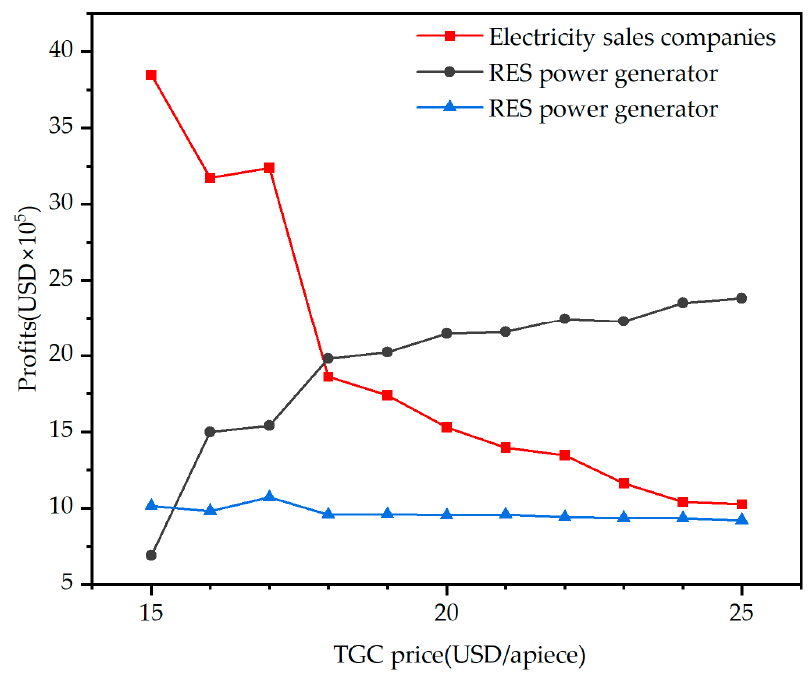
Figure 7. Profits of each transaction subject to electricity trading under different TGC prices.